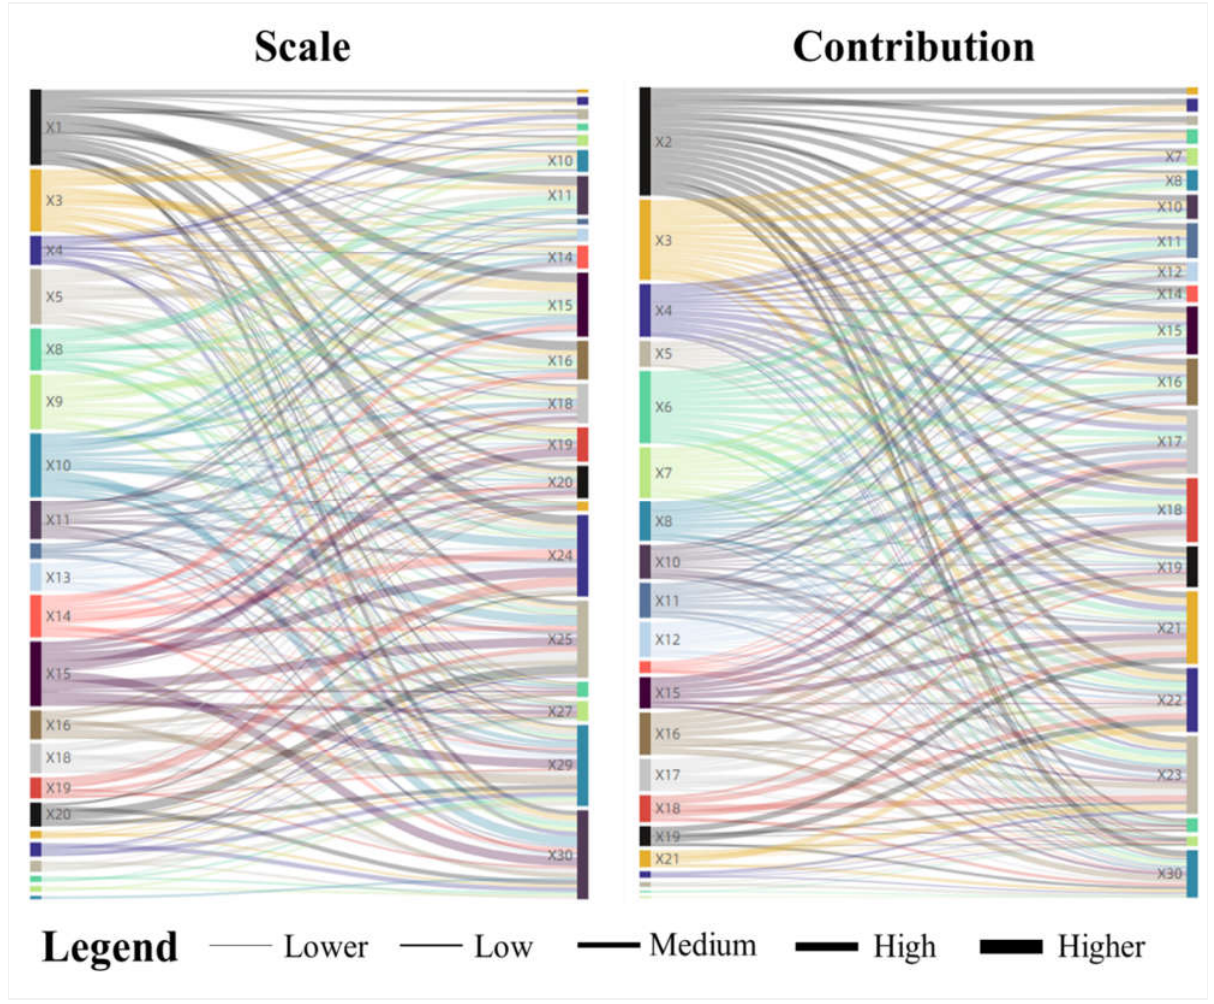
Figure 9. Analysis of interaction detector. The spatial differentiation drivers of real estate development are all bifactor or nonlin- ear enhanced with each other, with no independent or fading connection. For the industry scale, the factor pairs are dominated by bifactor enhancement and supplemented by nonlin- ear enhancement. There are 41 pairs with nonlinear enhancement, accounting for about 16%. Factor pairs with nonlinear enhancement include GDP ∩ expenditure ( X 1 ∩ X 4 ), GDP ∩ em- ployment in the tertiary industry ( X 1 ∩ X 11 ), GDP ∩ household registration population ( X 1 ∩ X 16 ), expenditure ∩ total retail sales of consumer goods ( X 4 ∩ X 5 ), expenditure ∩ per capita disposable income of residents ( X 4 ∩ X 6 ), expenditure ∩ employment in the sec- ondary industry ( X 4 ∩ X 10 ), expenditure ∩ employment in the tertiary industry ( X 4 ∩ X 11 ), expenditure ∩ output value of industry ( X 4 ∩ X 12 ), expenditure ∩ number of industrial enterprises above designated size ( X 4 ∩ X 13 ), expenditure ∩ output value of financial in- dustry ( X 4 ∩ X 14 ), expenditure ∩ urban population ( X 4 ∩ X 18 ), expenditure ∩